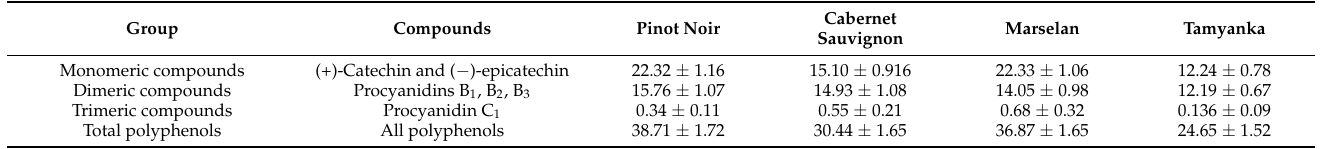
Table 4. Amounts of polyphenolic groups in GSEs, determined by HPLC (mg/g DW). Group Compounds Pinot Noir Monomeric